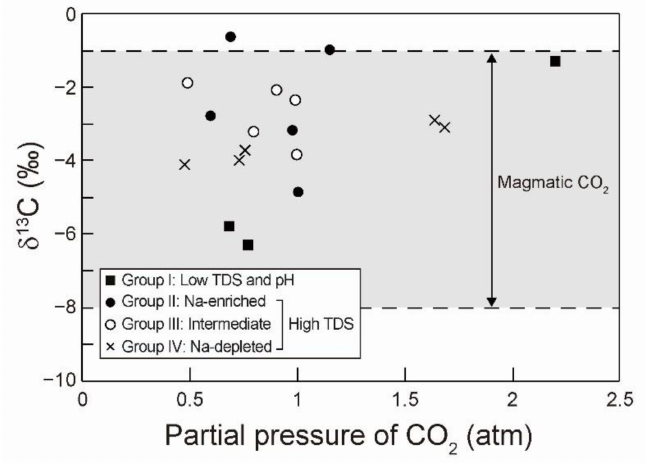
Figure 5. Partial pressure of CO 2 versus stable carbon isotopic composition of dissolved inorganic carbon ( δ 13 C) in water from the CO 2 -rich springs.